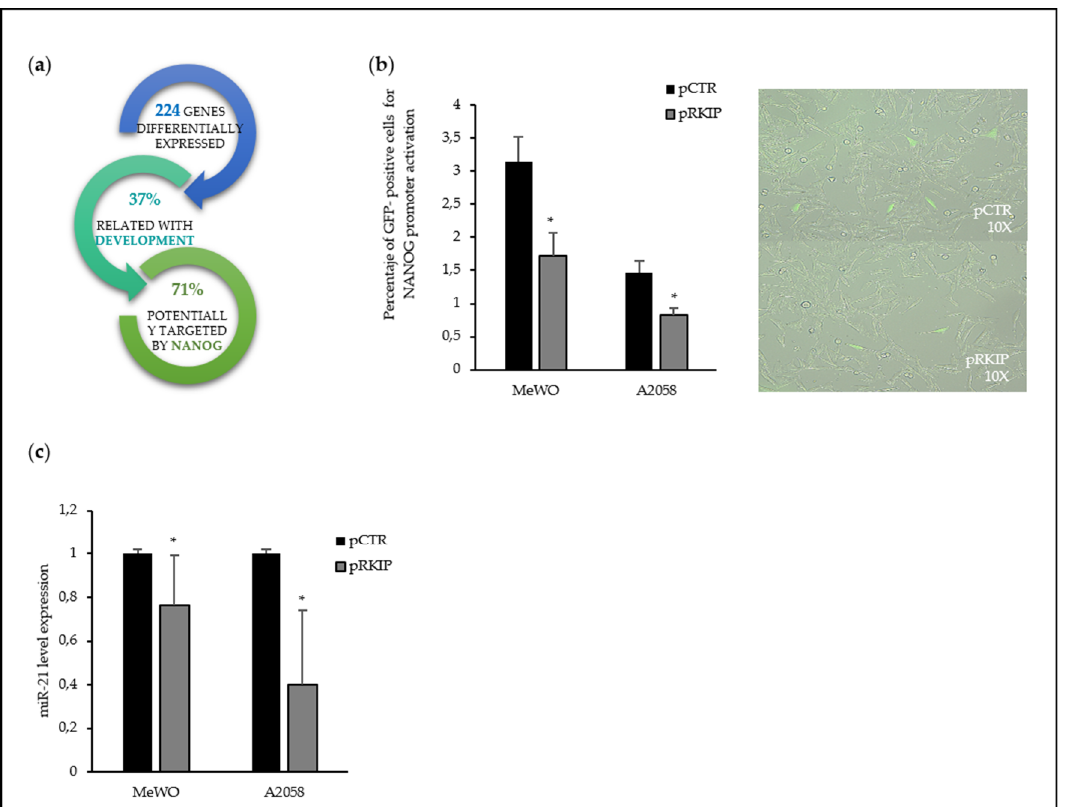
Figure 6. RKIP as a key regulator of NANOG expression in melanoma. ( a ) Overview of differential expressed genes after RKIP silencing related to development and NANOG transcription factor; ( b ) Co-transfection of RKIP overexpressing plasmid and GFP-NANOG promoter construct in MeWO and A2058 metastatic melanoma cell lines. It is shown the positive cells for GFP emission from three independent assays and a representative picture of one of the A2058 cells assay; ( c ) MicroRNA-21 level determination by RT-qPCR in RKIP upregulated melanoma cell lines RNU6-2 was used as reference mature miRNA. Average of three independent assays per cell line. * p -value < 0.05.